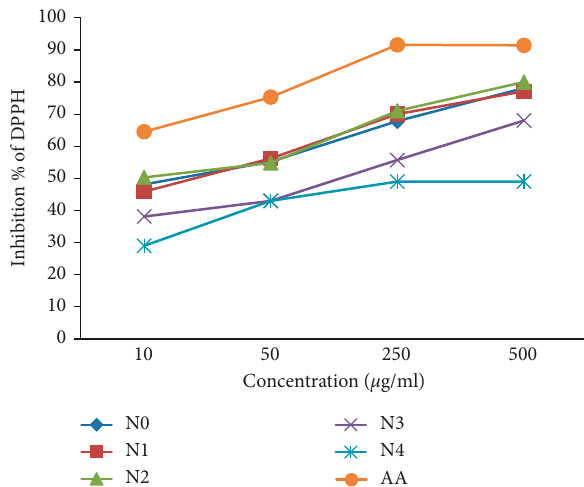
Figure 3: Effect of different levels of N on DPPH scavenging activity in hydromethanolic extracts of seeds of sesame.